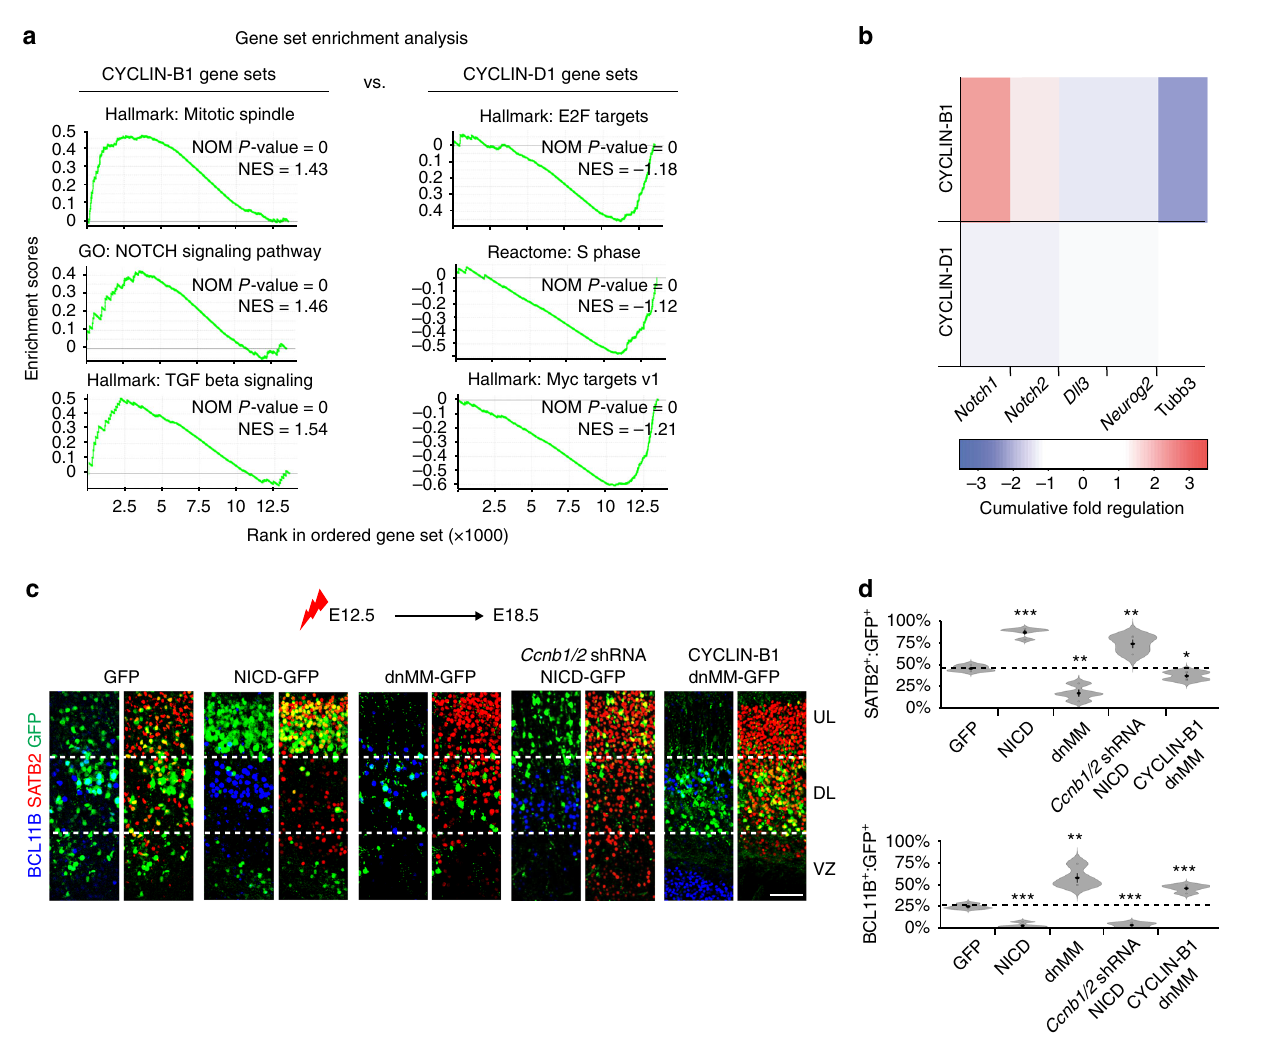
Fig. 8 CYCLIN-B1/2 delay lineage commitment via NOTCH activation. a GSEA terms enriched when comparing E13.5 cortical cells electroporated with CYCLIN-B1 versus CYCLIN-D1 for 24 h. b Cumulative effect on Notch1 , Notch2 and other genes implicated in neurogenesis, after overexpression and knockdown of CYCLIN-B1 or CYCLIN-D1 in cortical cells for 24 h. c , d Immunohistochemistry ( c ) and quanti fi cation ( d ) of GFP + cells (green) expressing BCL11B (blue) or SATB2 (red) in E18.5 cortices after misexpressing GFP alone or together with NICD, dnMM, NICD/ Ccnb1/2 shRNA, or dnMM/CYCLIN-B1 (green) at E12.5 ( n = 4 biological independent experiments). P -values BCL11B expression (vs. GFP); NICD 5.1e-5, dnMM 8.15e-3, Ccnb1/2 shRNA/NICD 5.2e-5, CYCLIN-B1/dnMM 4.71e-4, P -values SATB2 expression (vs. GFP); NICD 7.4e-5, dnMM 3.91e-3, Ccnb1/2 shRNA/NICD 7.51e-3, CYCLIN-B1/dnMM 0.035. Scale bar represents 40 µ m in ( c ). Violin plots are inset by rings corresponding to the individual data points, a fi lled dot at the group mean and a vertical line showing standard error. Stars indicate signi fi cant differences between indicated group and GFP based on two-tailed t tests, with * P < 0.05; ** P < 0.01 and *** P < 0.001. Source data are provided as a Source Data fi